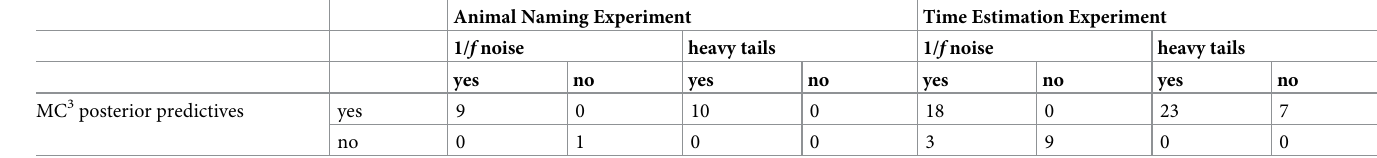
Table 2. Correspondence of 1/ f noise and heavy tails between human data and the MC 3 posterior predictive